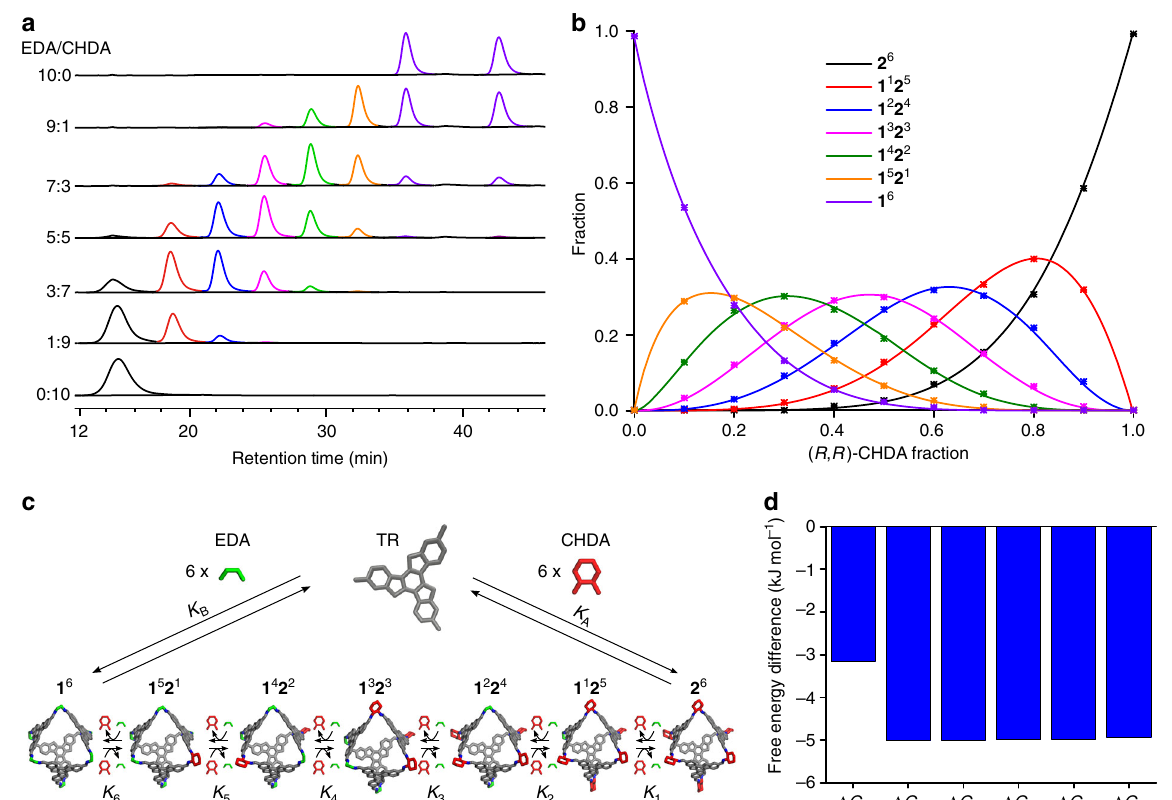
Fig. 5 Octahedra equilibrium distributions as a function of the EDA/CHDA ratio. a Individual HPLC spectra of the thermodynamic products formed at various ratios of EDA to ( R , R )-CHDA, b Fractions of the various octahedra species as derived from the HPLC spectra (symbols) and as fi tted with the mass-balance model (lines), c Schematic of the mass-balance model, and d free energy differences between subsequent octahedra ð K i ¼ e Δ G i = RT Þ corresponding to the fi t in ( b